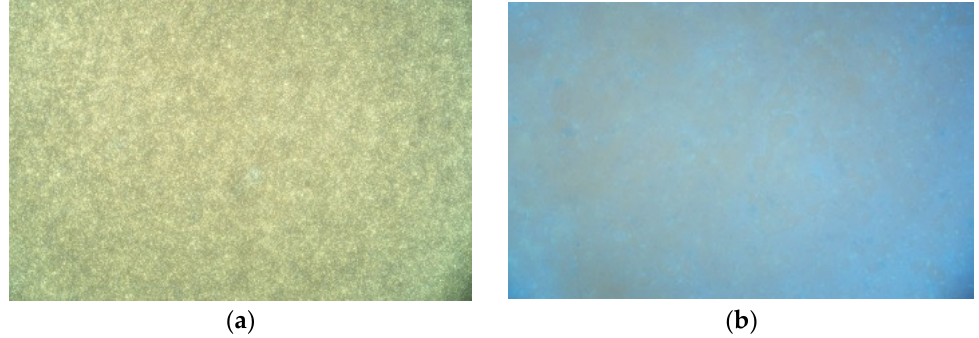
Figure 6. Fluorescent micro-structure of WE/A with 5% WER ( a ) 1 h; ( b ) 48 h.